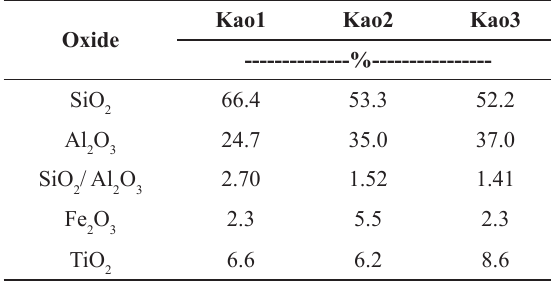
Chemical composition of Kao1, Kao2 and Kao3 obtained by X-ray